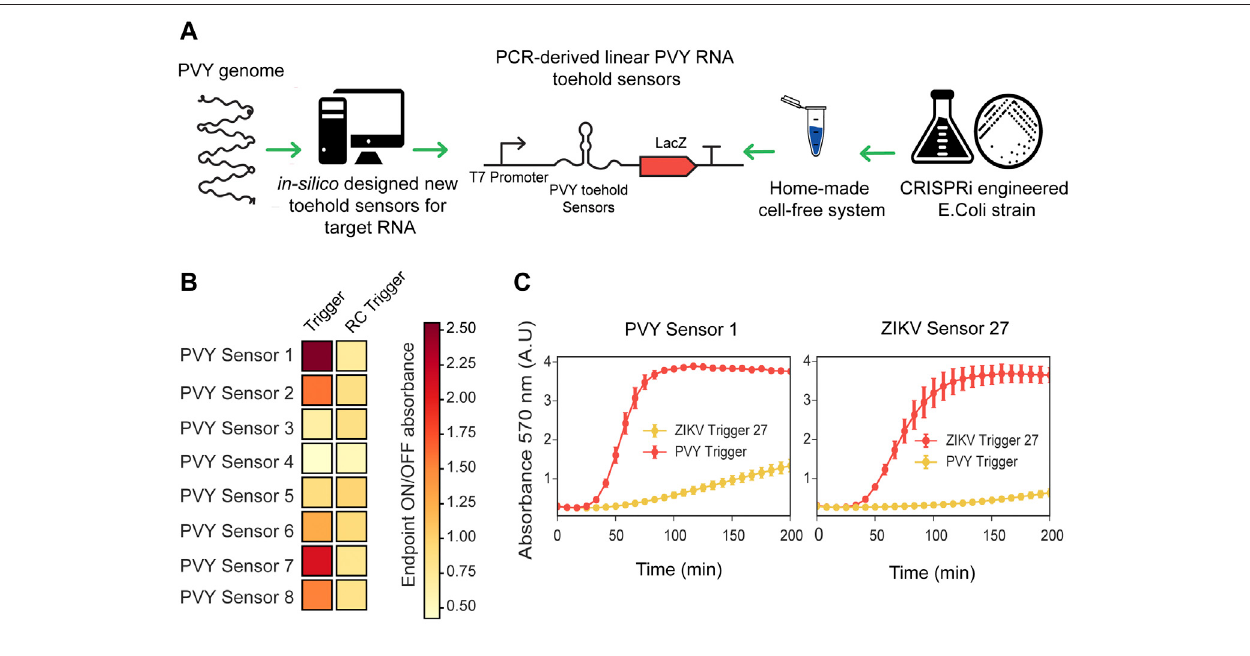
FIGURE3 | Fast prototyping de-novo designed sensors in low-cost optimized cell-free systems. (A) Scheme representation offast prototyping de-novo designed RNA toeholds sensors against synthetic fragments of PVY virus. (B) PCR-puri fi ed transcriptional units (at 10 nM fi nal concentration) encoding for PVY RNA toehold sensorswereincubatedwithsyntheticRNAdirectorRNAreversecomplementary(RC)(at300 nM fi nalconcentration)andabsorbanceat570 nmwasmeasuredinplate reader. Endpoint ON/OFF absorbance was calculated at 200 min with respect to an untriggered control. Heatmap values correspond to the average of six experimental replicates from two PCR ampli fi cations performed on different days. (C) PVY Sensor 1 and ZIKV Sensor 27 encoded in plasmids (at 3.5 nM fi nal concentration) were incubated with ZIKV Trigger 27 RNA or with PVY Trigger RNA (at 480 nM fi nal concentration). Plotted values correspond to arithmetic mean and standard deviation of two independent